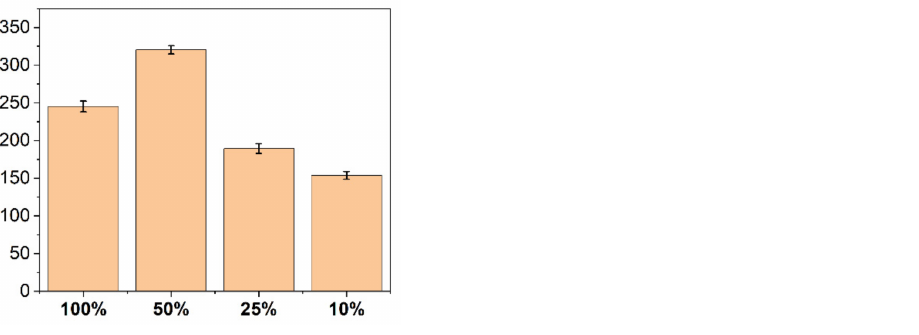
Figure 3. ∆ Rct of MPA/ME/Au with MPA volume percentage of 100%, 50%, 25%, and 10% for detecting CA19-9.